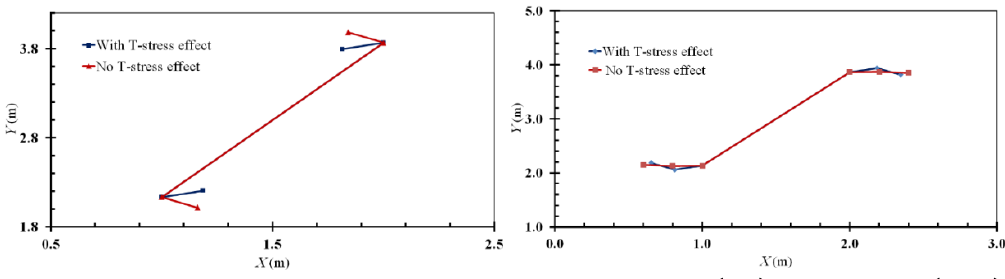
Figure 12. 60-degrees slanted center crack: under compression (left), under tension